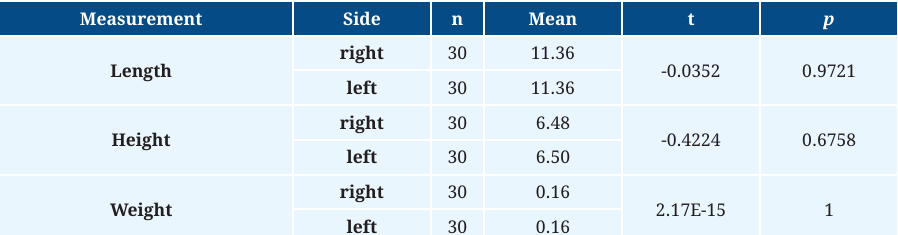
TABLE 3 | Lutjanus argentiventris otholith